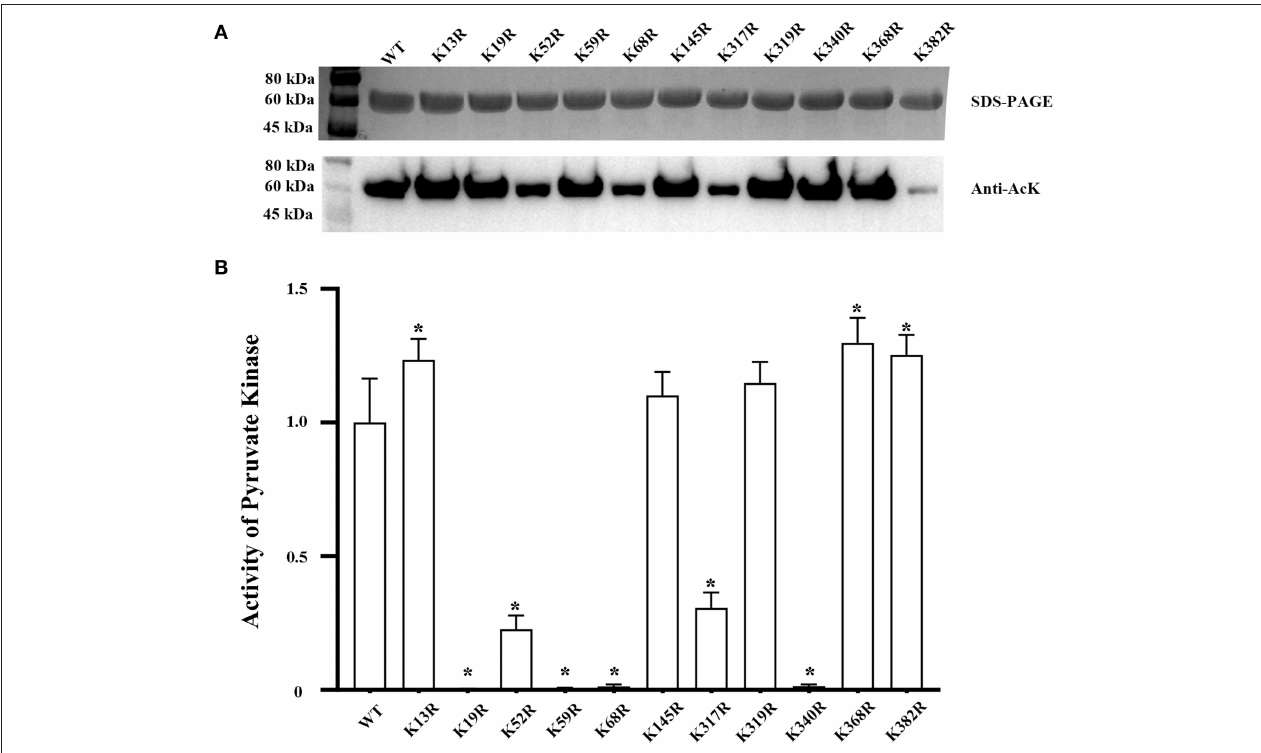
FIGURE 1 | (A) Top line, SDS-PAGE and Western blot analysis of purified PykF and its acetylated variants from BL21 (DE3) cells. The acetylated variants with mutation of a single lysine site in PykF to glutamine. Lane 1, wild-type PykF; Lane 2, PykF-K13Q; Lane 3, PykF-K19Q; Lane 4, PykF-K52Q; Lane 5, PykF-K59Q; Lane 6, PykF-K68Q; Lane 7, PykF-145Q; Lane 8, PykF-K317Q; Lane 9, PykF-K319Q; Lane 10, PykF-K340Q; Lane 11, PykF-K368Q; Lane 12, PykF-K382Q. The same amount of protein was loaded. Anti-AcK: anti-acetyl lysine antibody. Bottom line, pyruvate kinase activity of PykF and its acetylated variants. Pyruvate kinase activity of the wild-type PykF was set as 1. Mean values and standard deviations were calculated based on three replicates ( n = 3). (B) Top line, SDS-PAGE and Western blot analysis of purified PykF and its deacetylated variants from BL21 (DE3) cells. The deacetylated variants with mutation of a single lysine site in PykF to arginine. Lane 1, wild-type PykF; Lane 2, PykF-K13R; Lane 3, PykF-K19R; Lane 4, PykF-K52R; Lane 5, PykF-K59R; Lane 6, PykF-K68R; Lane 7, PykF-145R; Lane 8, PykF-K317R; Lane 9, PykF-K319R; Lane 10, PykF-K340R; Lane 11, PykF-K368R; Lane 12, PykF-K382R. The same amount of protein was loaded. Anti-AcK, anti-acetyl lysine antibody. Bottom line, pyruvate kinase activity of PykF and its deacetylated variants. Pyruvate kinase activity of the wild-type PykF was set as 1. Mean values and standard deviations were calculated based on three replicates ( n = 3). Two-tailed P -values were determined by the t -test, and the significance level is 0.05. * p < 0.05.